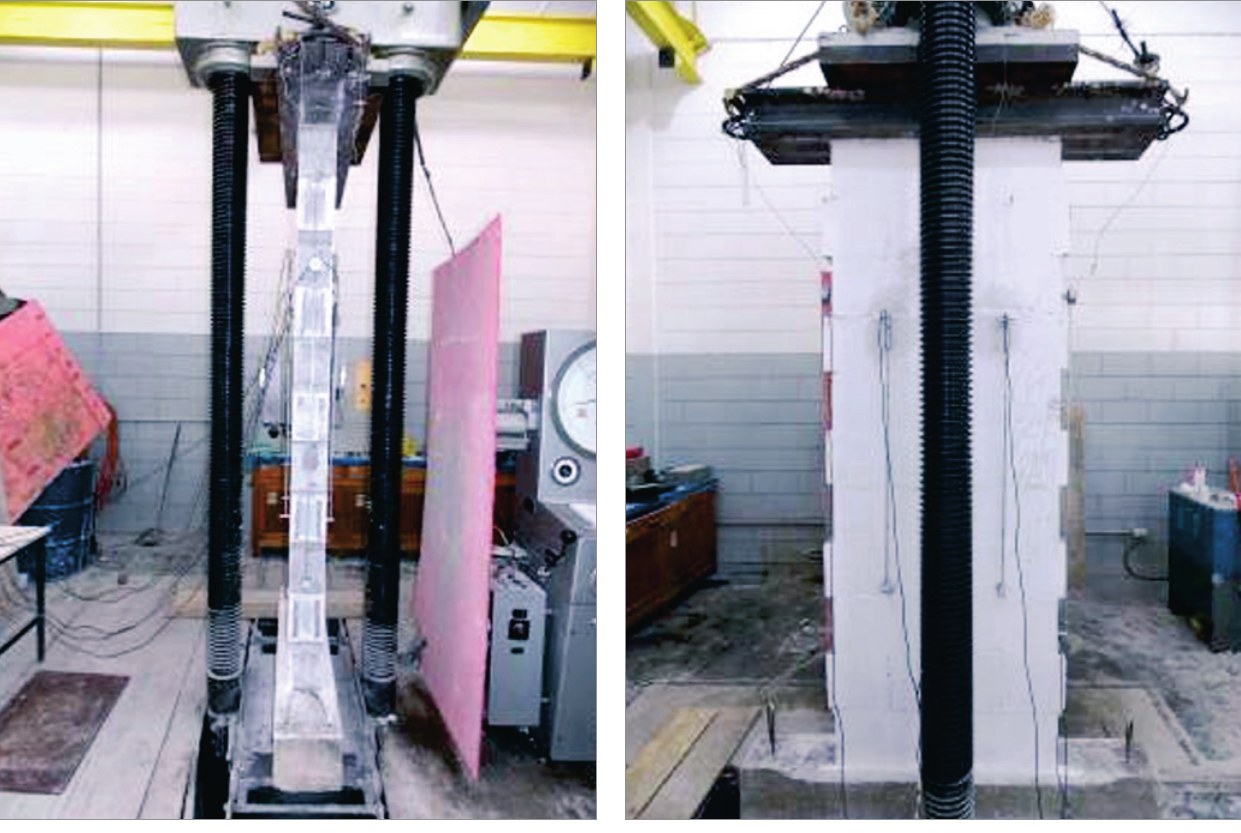
Figura 16 Configuração do ensaio das paredes, grupo 1 e 2